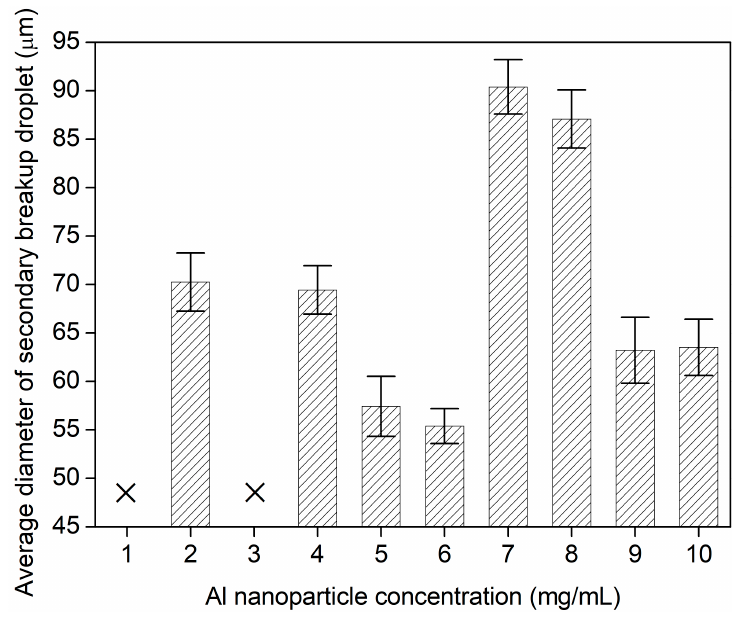
Figure 6. The average diameters of secondary breakup sub droplets at different Al nanoparticle concentrations. Table 3. The C ’ /E value at the point of disintegration.